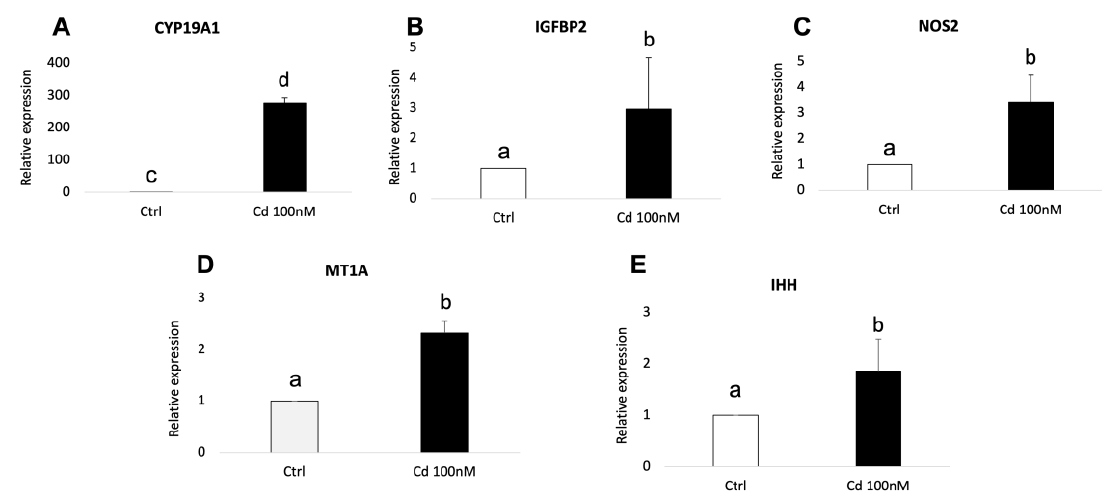
Figure 6. Relative expression of DEGs in CCs of adult sheep evaluated by Real-Time PCR. CYP19A1 ( A ), IGFBP2 ( B ), NOS2 ( C ), MT1A ( D ) and IHH ( E ) were upregulated upon CC exposure to 100nM of CdCl 2 . Student’s t -test: a,b p < 0.05; c,d p < 0.01.